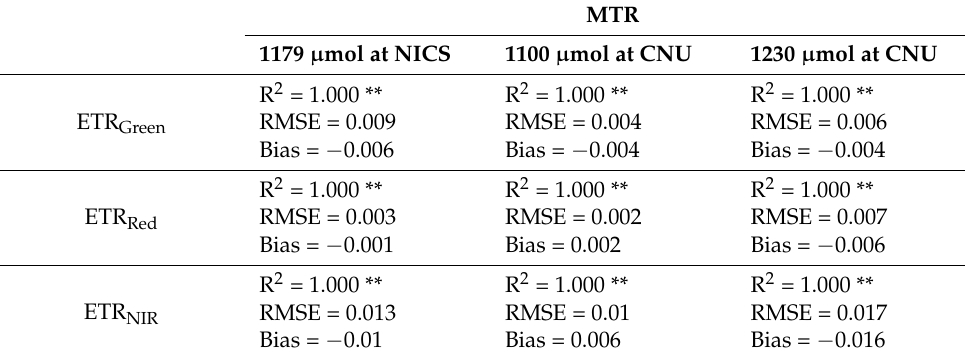
Table 3. Coefficient of determination (R 2 ) and root mean square error (RMSE) between the estimated tarp reflectances at the green (ETR Green ), red (ETR Red ), and NIR (ETR NIR ) and measured tarp re- flectances (MTR) at different light intensities of 1179 µ mol at the National Institute of Crop Science (NICS) and 1100 µ mol and 1230 µ mol at Chonnam National University (CNU).